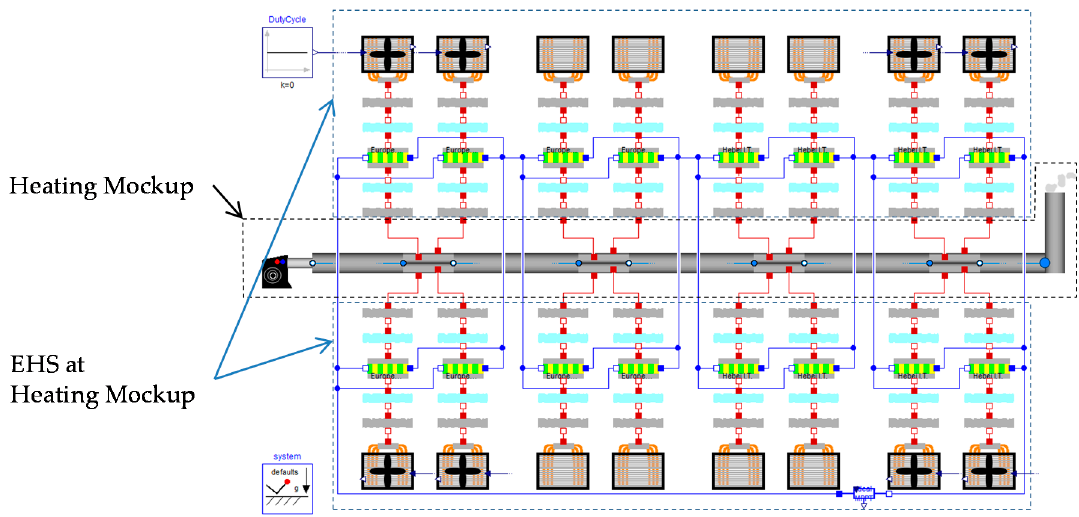
Figure 8. Simulation model of the thermoelectric EHS at the heating mockup.